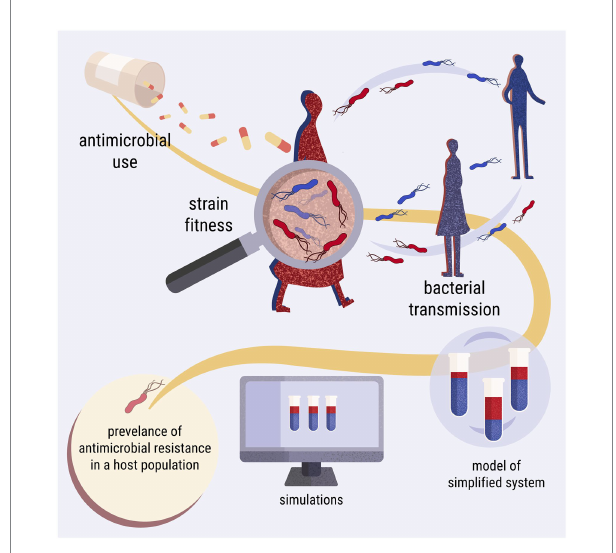
FIGURE 1 Graphical overview of the simulation study. The model describes a population of hosts, carrying two bacterial strains, one susceptible (blue) and one resistant (red) to an antimicrobial agent. The aim of the study is to theoretically investigate how three key processes (antimicrobial use, strain fitness, and bacterial transmission) affect the prevalence of antimicrobial resistance in this